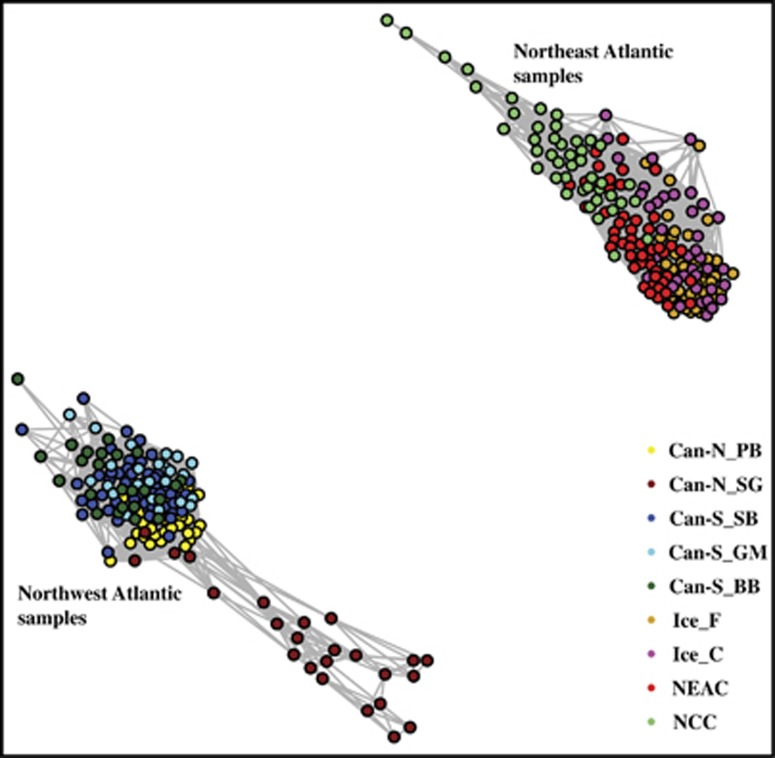
Neutral population divergence between Atlantic cod populations. Population clustering based on 7075 neutral SNPs in 316 individuals of Atlantic cod, using an isolation-by-state (IBS) matrix constructed in PLINK, visualized using the NETVIEW P pipeline at k=50, capturing large-scale genetic differentiation across the Atlantic as well as fine-scale structuring within the Northwest and Northeast Atlantic populations. Edge width is proportional to the genetic distance between individuals. Can-N_PB, Placentia Bay; Can-N_SG, Southern Gulf of St Lawrence; Can-S_SB, Sambro; Can-S_GM, Gulf of Maine; Can-S_BB, Browns Bank; Ice_F, Iceland Frontal; Ice_C, Iceland Coastal; NEAC, Northeast Arctic cod; NCC, Norwegian coastal cod.